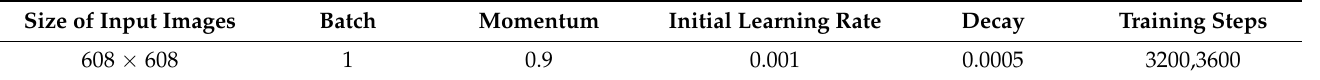
Table 1. Initialization parameters of YOLOv3